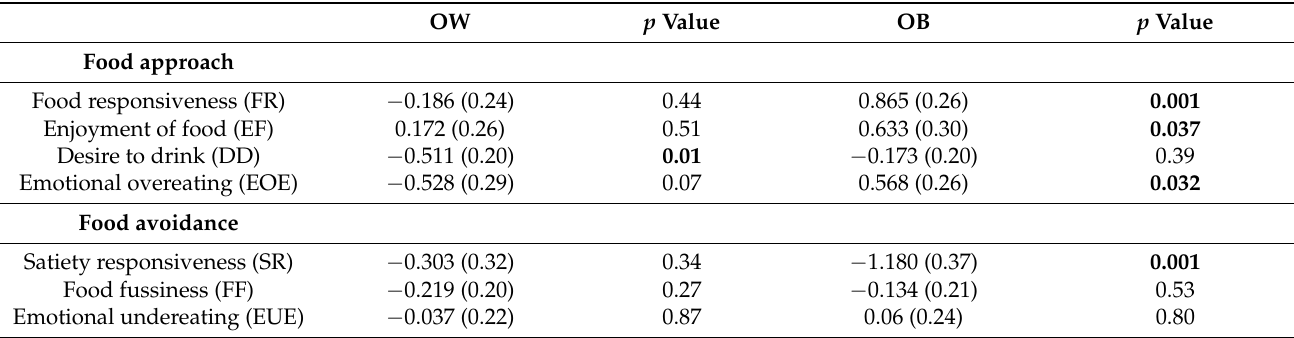
Table 3. Multinomial regression analysis for the overweight and obese groups (reference category: normal weight (NW)) in the child eating behavior questionnaire (CEBQ) subscale (adjusted for age, gender, and maternal education).